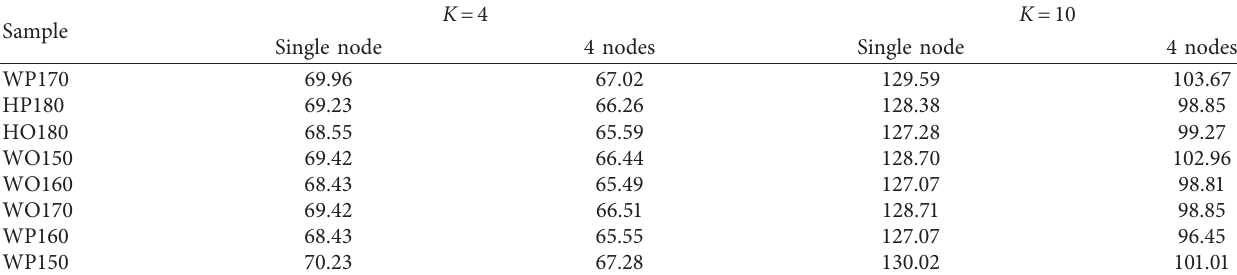
Table 10: Single node v/s multiple Hadoop nodes execution time (sec) for dry